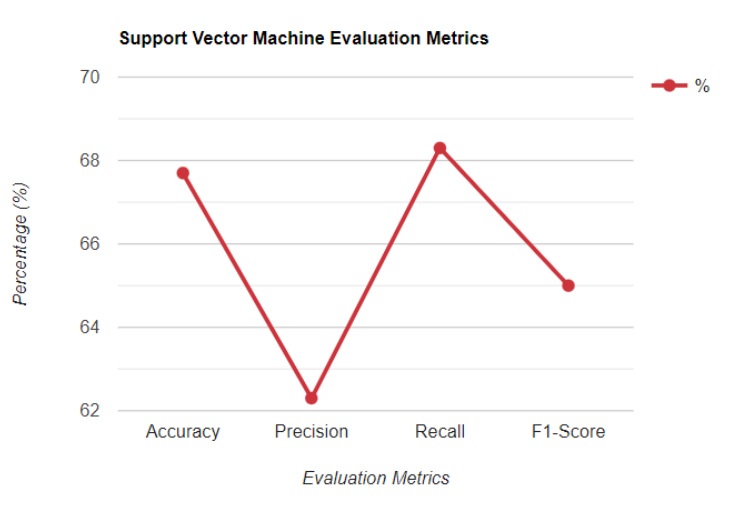
Figure 7. The SVM Classifier Prior